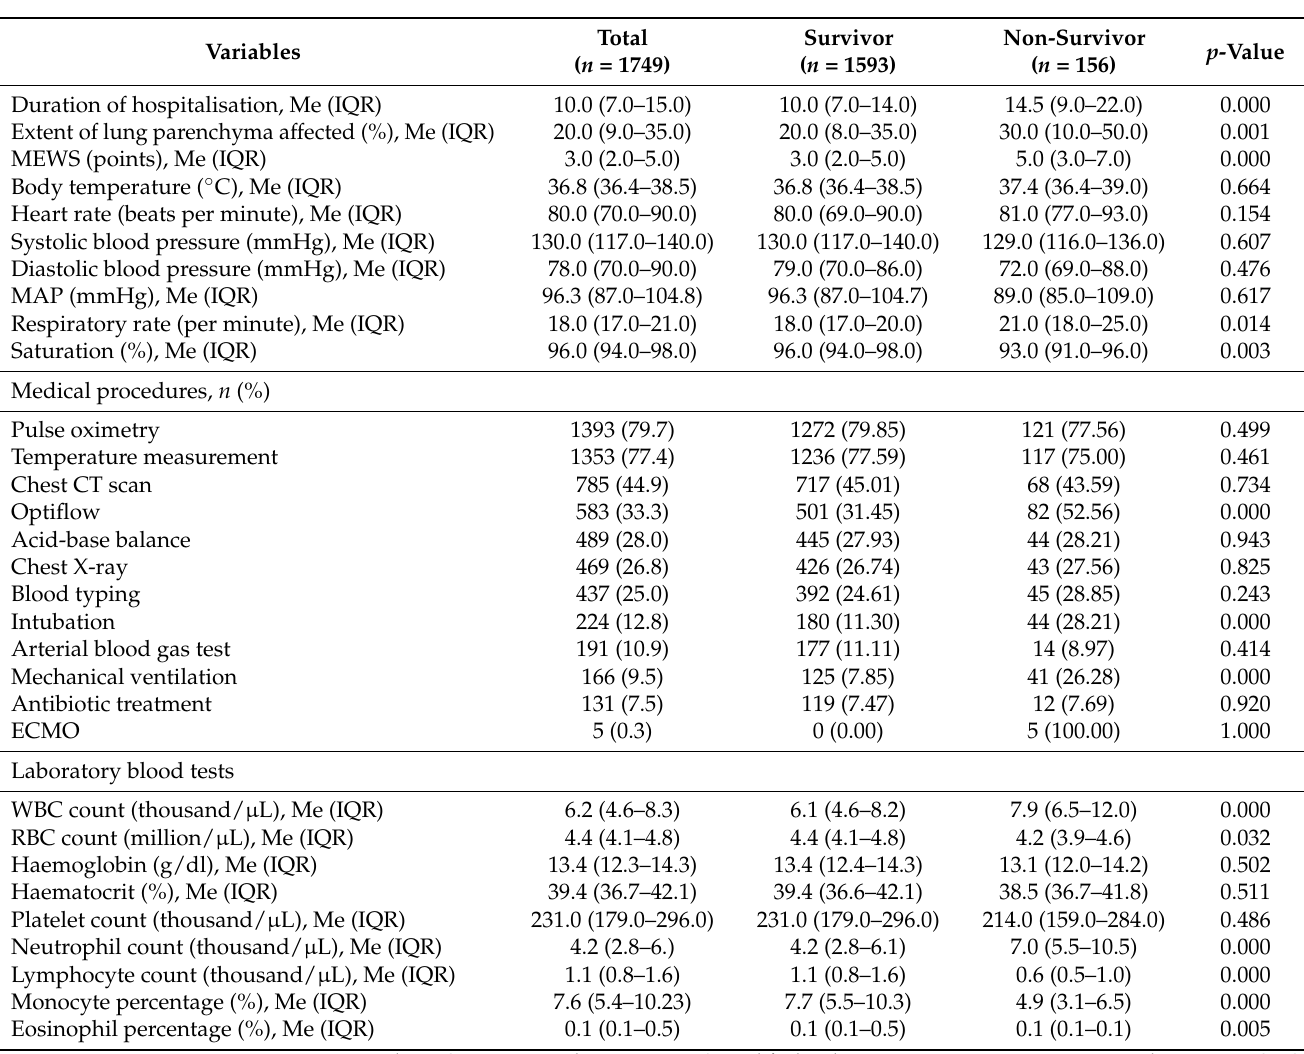
Table 2. Clinical characteristics of patients and associations between mortality and selected clini- cal